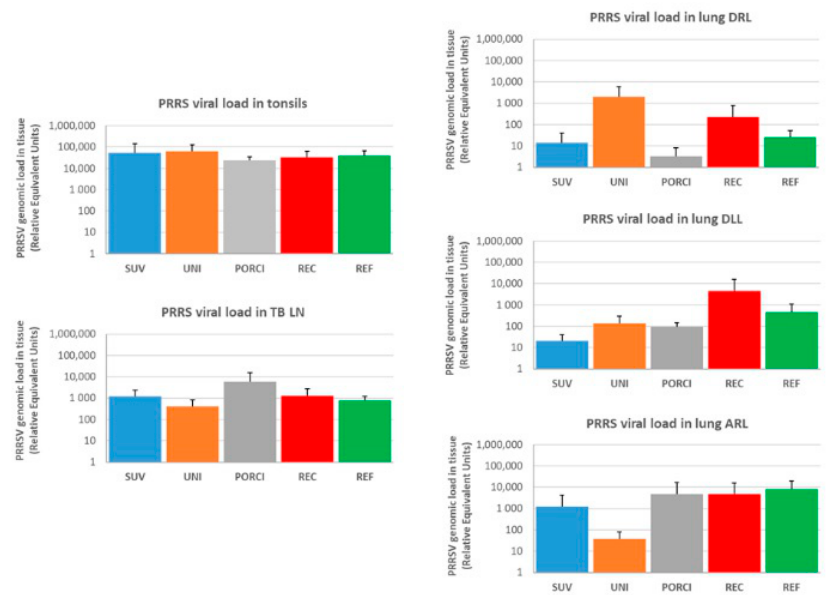
Figure 5. Viral load measured by qRT-PCR (REU) in the lung Diaphragmatic Right lobe (DRL), lung Diaphragmatic Left Lobe (DLL), lung Apical Right lobe (ARL), tonsils and tracheobronchial lymph nodes (TB LN). The SUV, UNI and PORCI groups were vaccinated with the vaccines Suvaxyn PRRS, Unistrain or Porcilis PRRS at dpv 0 and challenged with REC at dpv 28. The REC and REF groups were unvaccinated and challenged with the REC or REF strains at dpv 28.